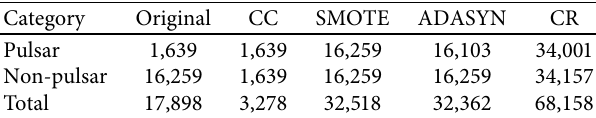
Figure 2: The flow of the proposed methodology. Table 6: Number of pulsar and non-pulsar samples after data resampling before data splitting.